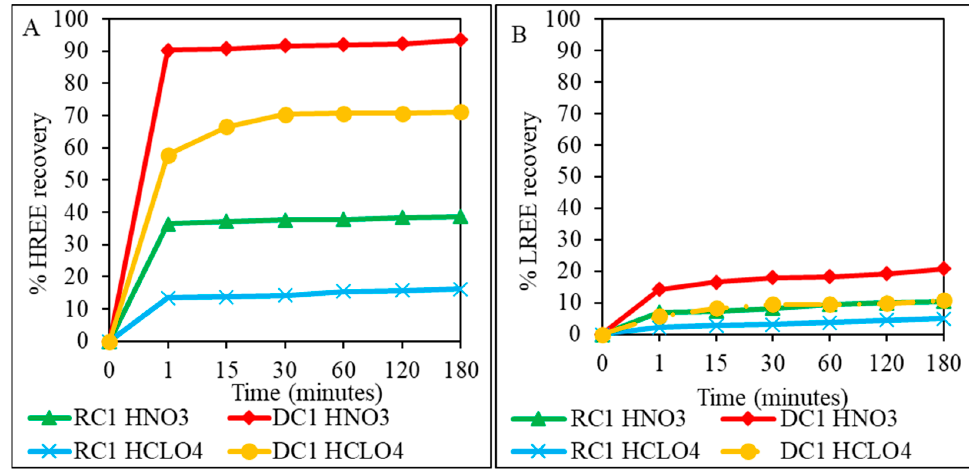
Figure 8. RC1 and DC1 % HREEs ( A ) and % LREEs ( B ) leaching recovery under the optimised leach ‐ ing parameters (HClO 4 /HNO 3 concentration of 2 M, solid:liquid ratio of 10 g/L, leaching tempera ‐ ture of 50 °C, D 90 = − 106 μ m, stirrer speed 550 rpm).